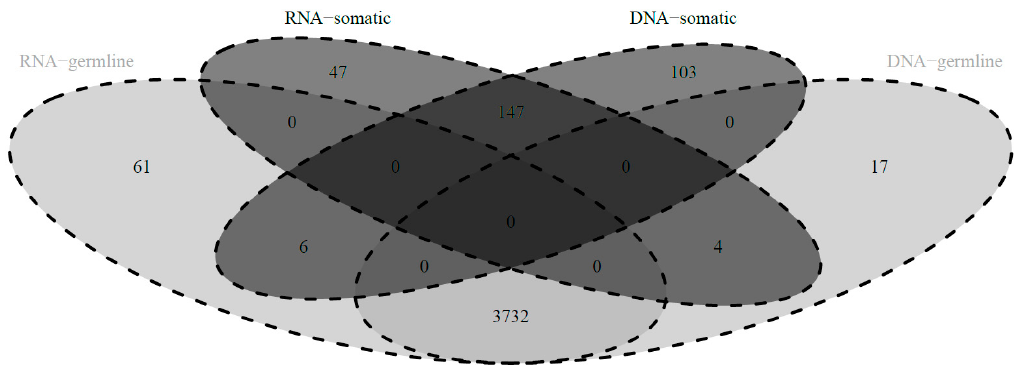
Figure 2. Classification of variants detected in the mitochondrial RNA and in the mitochondrial DNA of 165 primary breast tumor cases. Venn-diagram depicting classification of variants as either somatic (black) or germline (grey) at the RNA level and the DNA level.